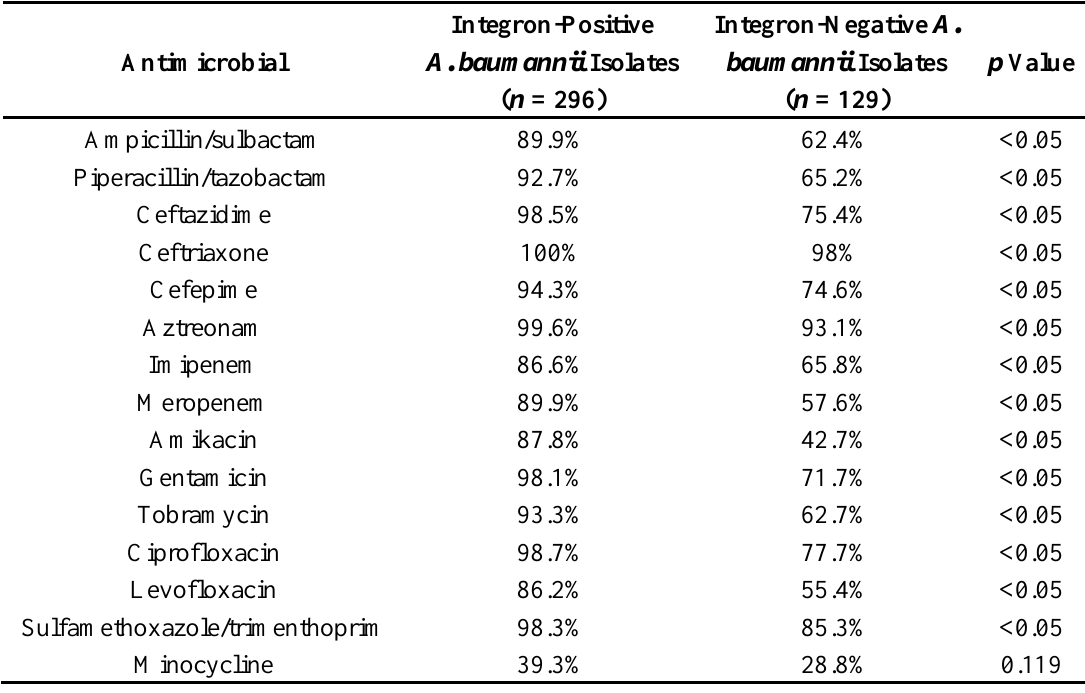
Table 3. Comparison of the prevalence of antimicrobial resistance between integron-positive and -negative Acinetobacter baumannii isolates. Integron-Positive Integron-Negative A. Antimicrobial A. baumannii Isolates baumannii Isolates p Value ( n = 296) ( n = 129) Ampicillin/sulbactam 89.9%